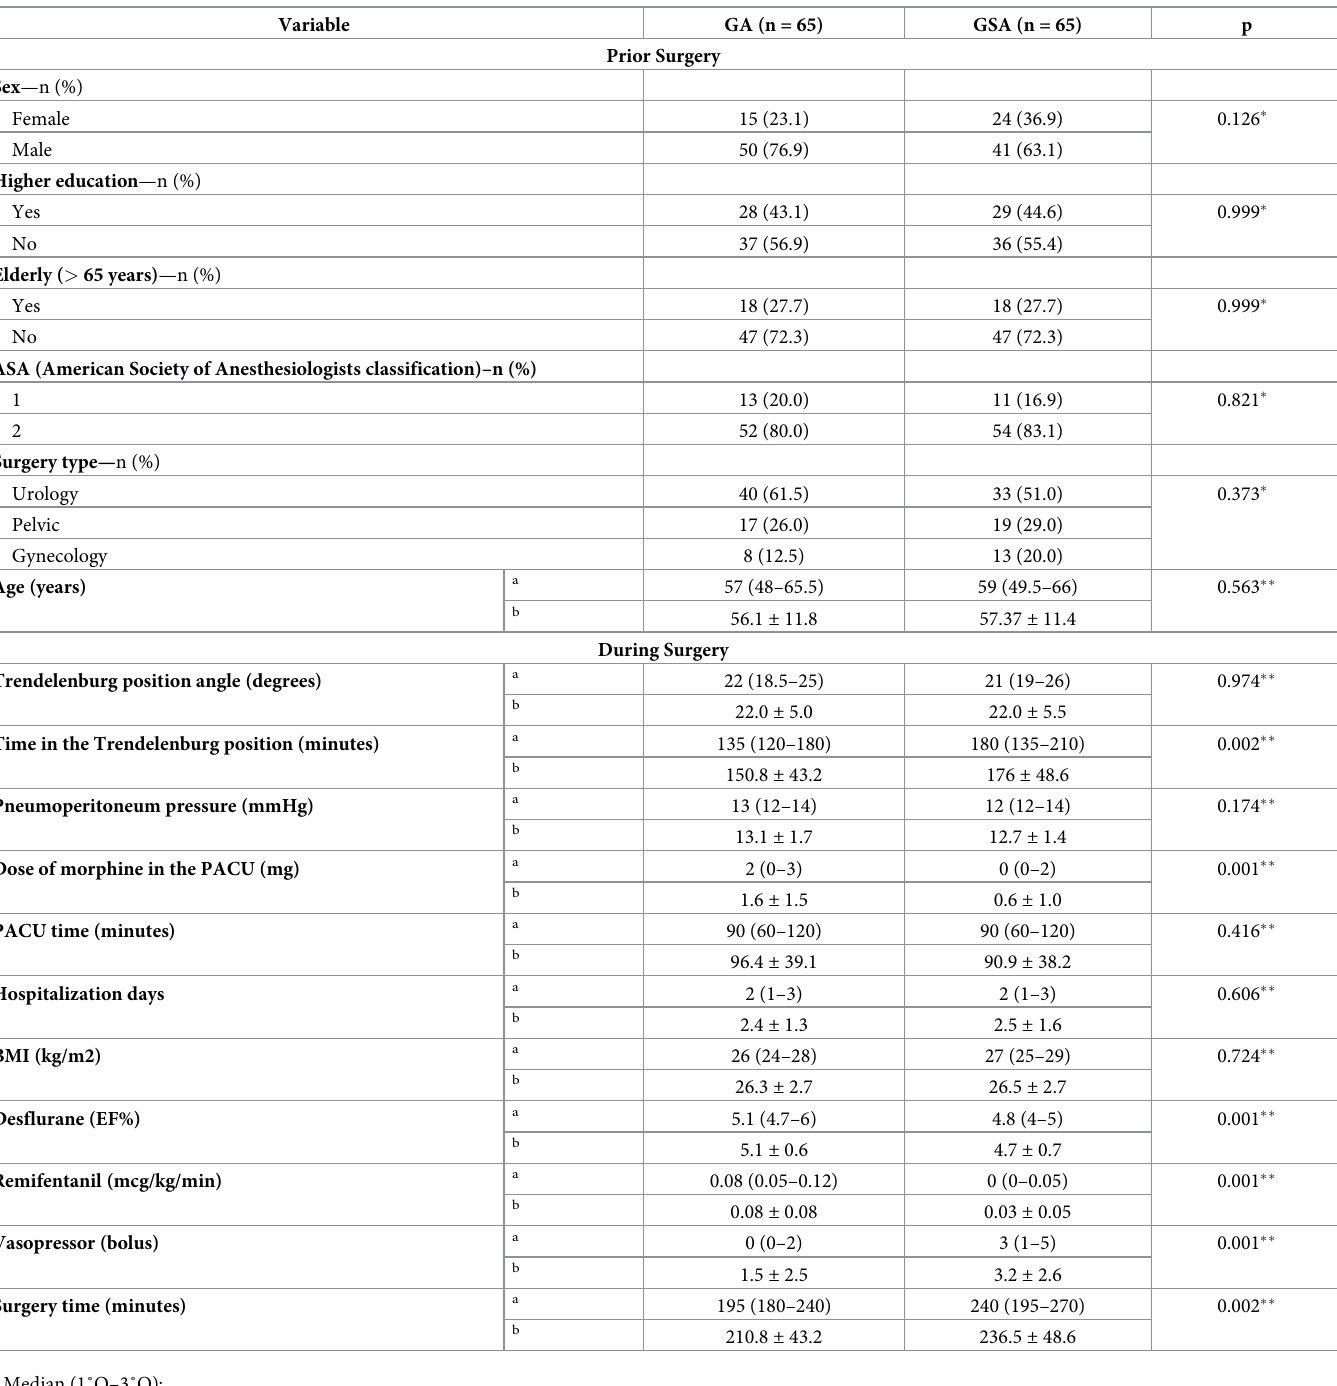
Table 3. Clinical and demographic characteristics according to